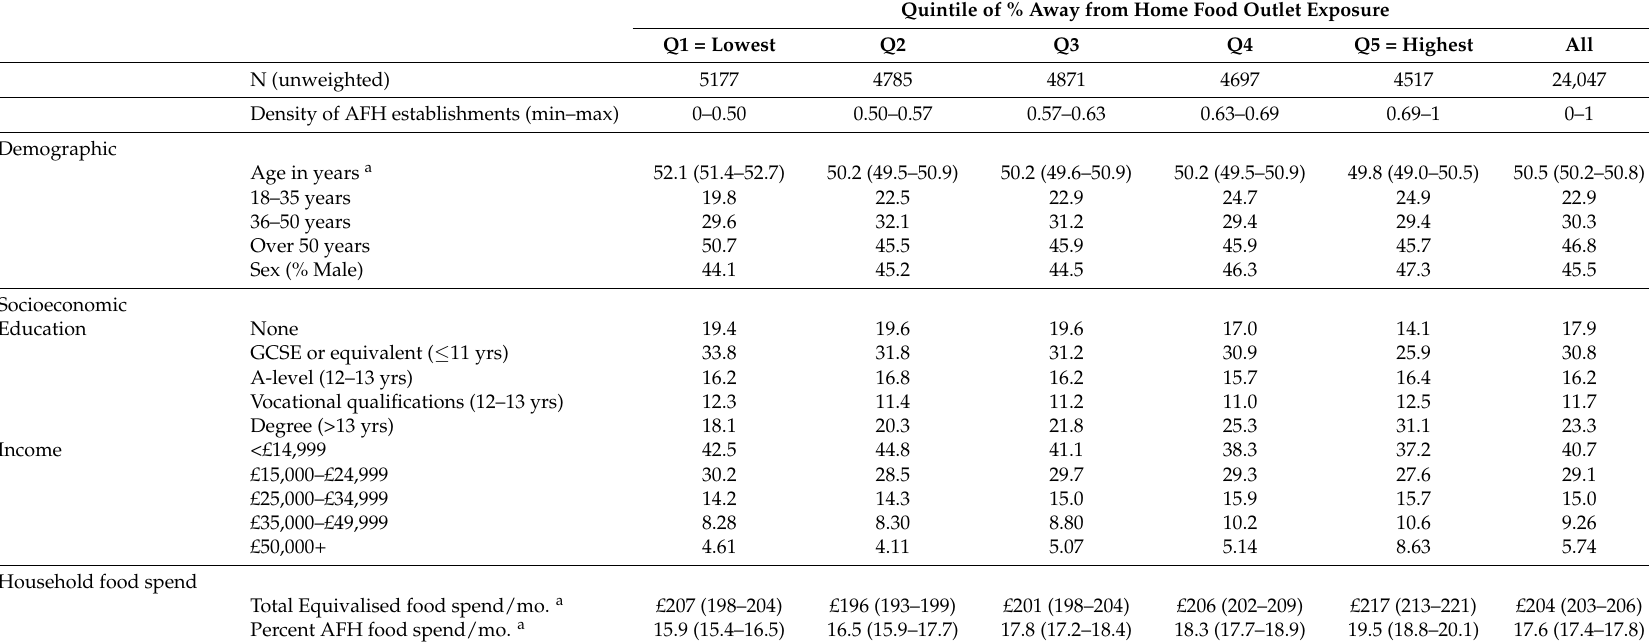
Table 2. Weighted sample characteristics ( n = 24,047) as column percentages (unless otherwise stated) by quintile of proportion of away from home food outlet